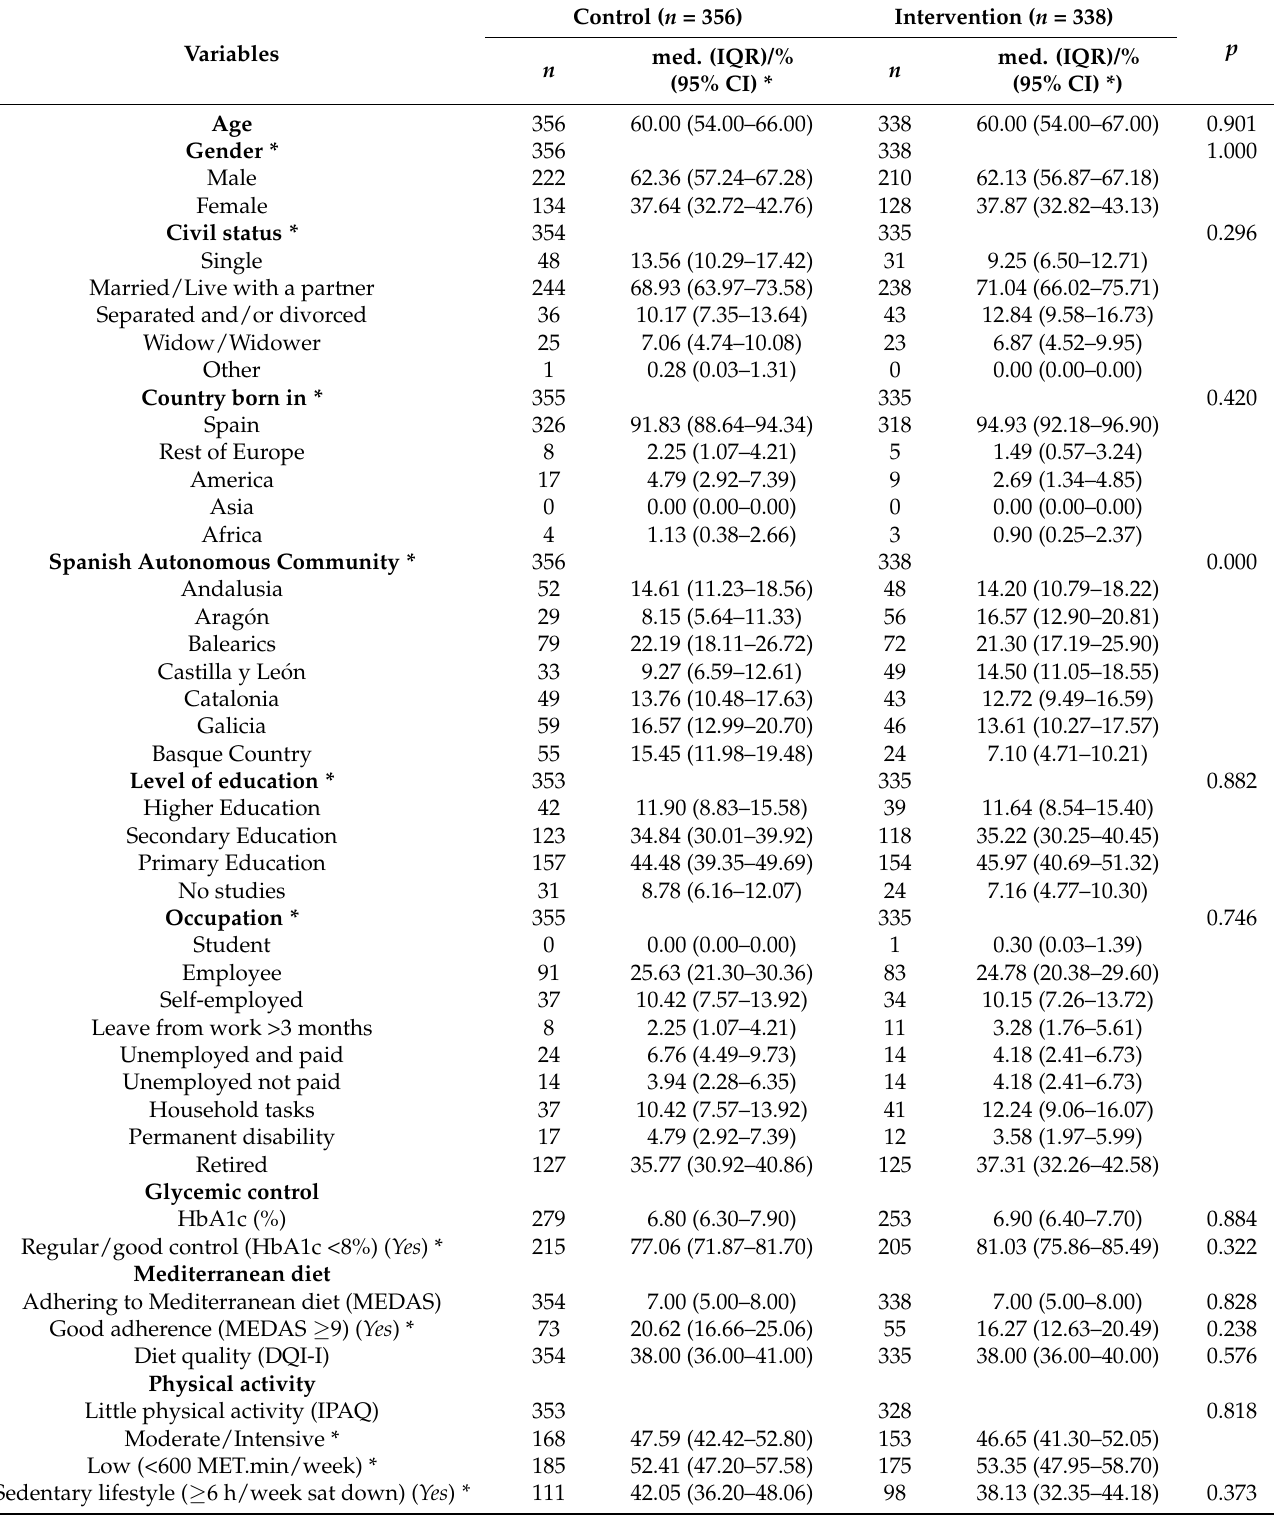
Table 1. Baseline characteristics of the patients with diabetes